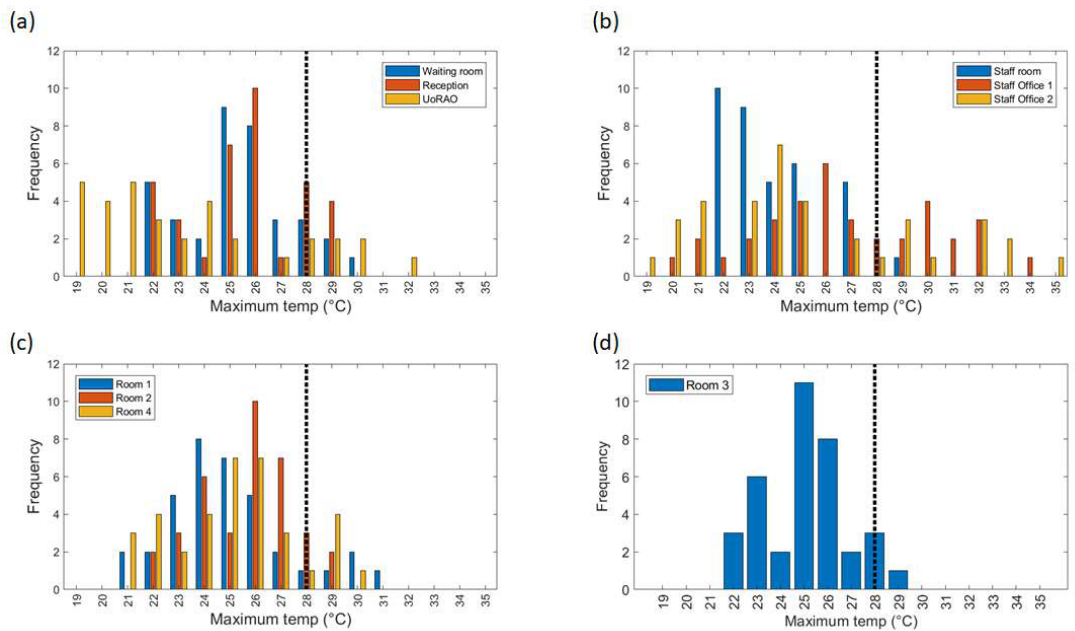
Figure 9. Maximum daily temperatures recorded in all rooms across all weekday measurements. For clarity, similar rooms are plotted on one subplot (a) Waiting room, Reception and the observatory (UoRAO), (b) Staff room and Staff offices, (c) Room 1,2, 4 and (d) Room 3. All plots have the same axis. The vertical dashed line denotes an upper threshold of 28 °C.